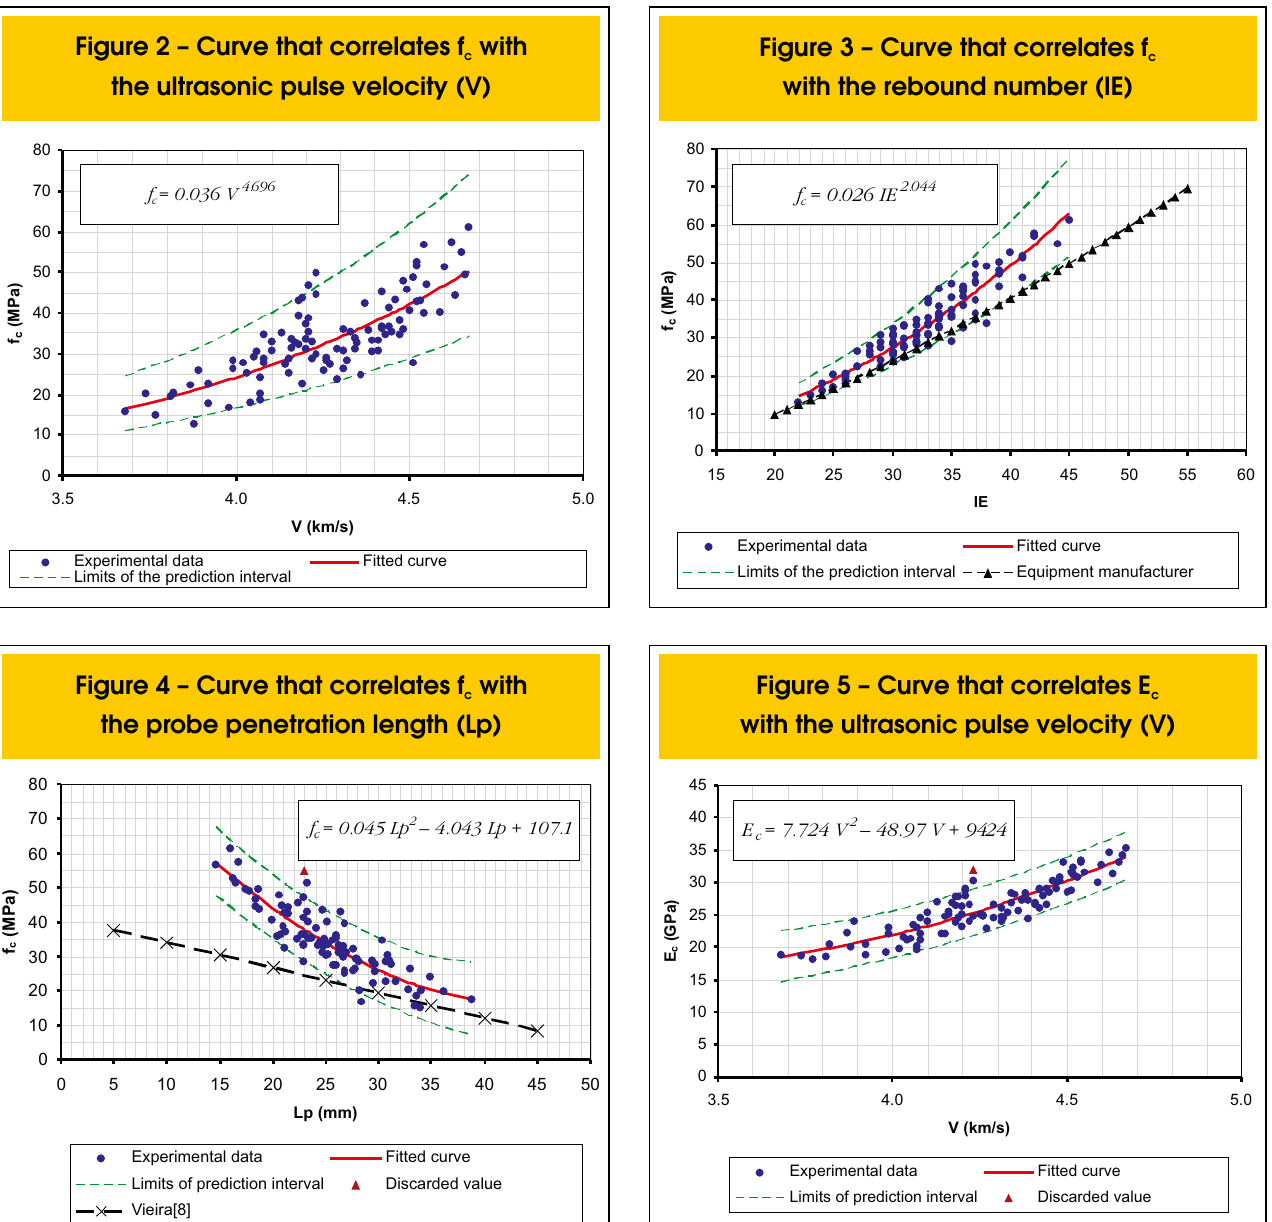
Figure 2 – Curve that correlates f with